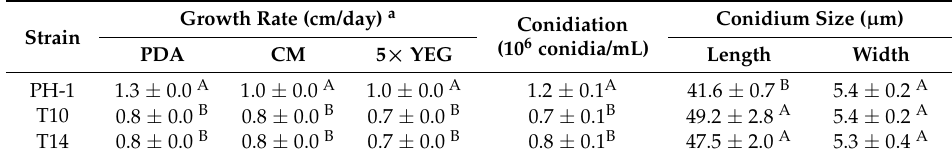
a Growth rate and conidiation were measured after incubation for three and five days, respectively. Mean and standard deviation were calculated from three independent replicates. Data were analyzed with Duncan’s multiple range test. The same capitalized letter indicated that there was no significant difference. Different capitalized letters were used to show statistically significant difference ( p < 0.05). PDA, potato dextrose agar; CM, complete medium; YEG, Yeast Extract